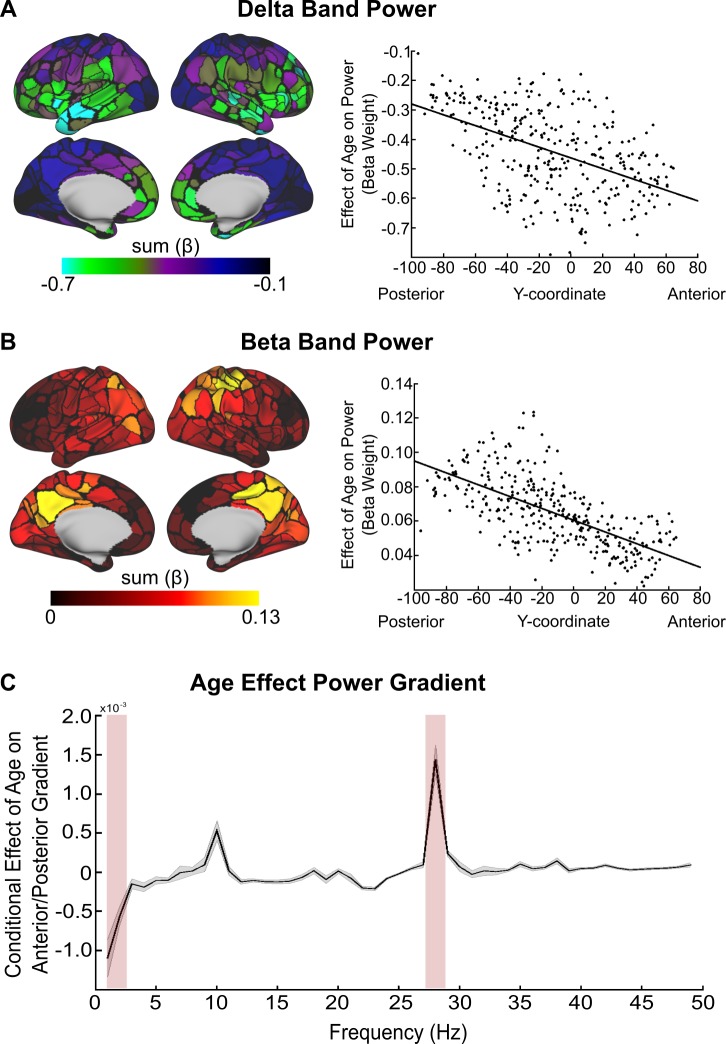
Regional age-related differences in power.(A) Regional age-related decreases in delta band power. (B) Regional age-related increases in beta band power. Scatter plots contain summed regional age effect (beta weight from Power × Age model) as a function of the region’s anatomical y-coordinate center of mass. (C) Power × Age anatomical gradient as a function of frequency. Error bars represent standard error of the model fit. Red shaded bar denotes delta and beta band regimes from panels A and B. y-Axis represents the beta weight (slope) of the relationship between power and age with the anatomical y-coordinate of the region’s center of mass. See S1 Data for individual data points.